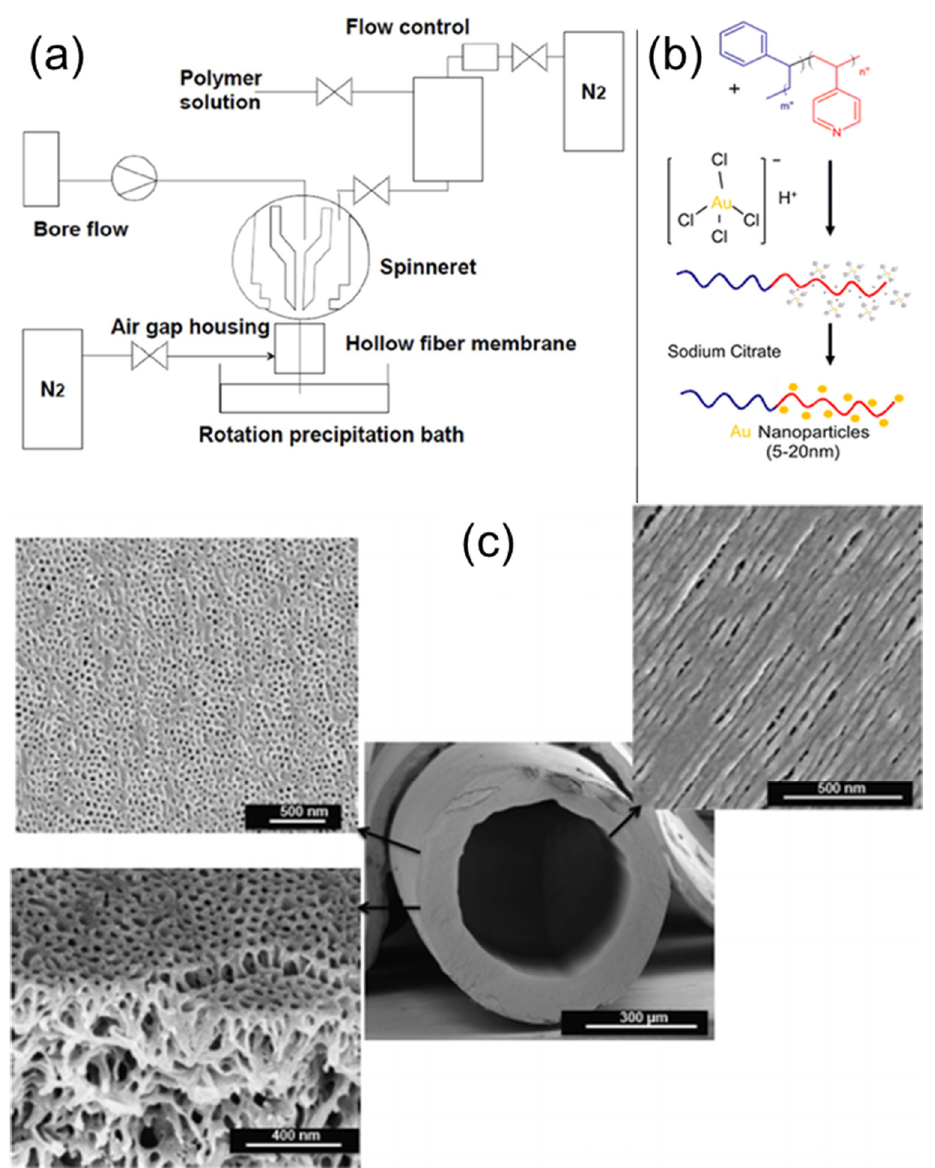
Figure 18. ( a ) Hollow fiber dry/wet spinning set-up. ( b ) Preparation of catalytic membranes by treatment with gold salts, followed by reduction with sodium citrate. ( c ) SEM image of PS- b -P4VP hollow fiber prepared via the dry/wet spinning method, with magnified SEM images of the outer and inner surface morphologies, as well as internal membrane morphology. Adapted from [48].